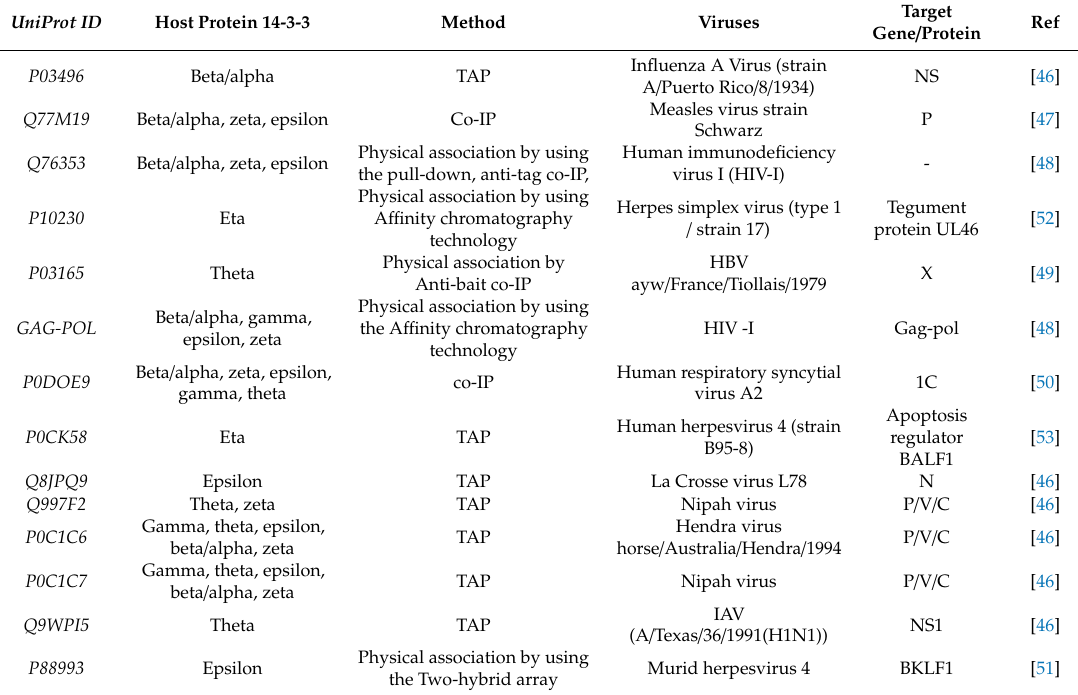
Table 1. Summary of virus–host protein (14-3-3) interactions using di ff erent methods. UniProt